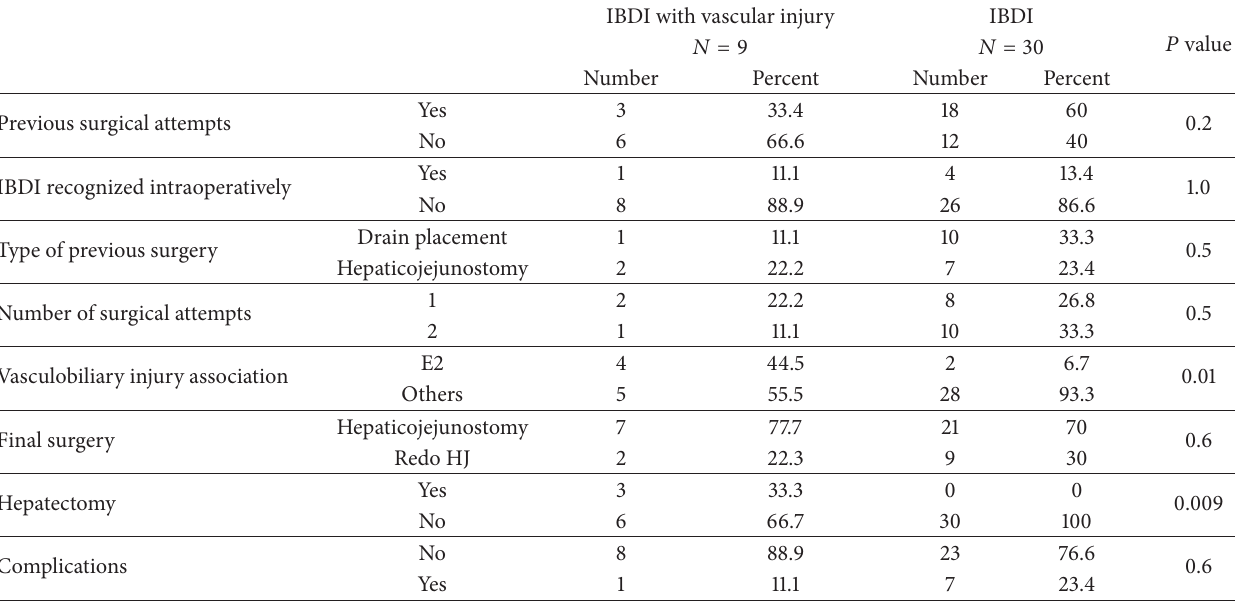
Table 4: Comparison between patients IBDI with and without vascular